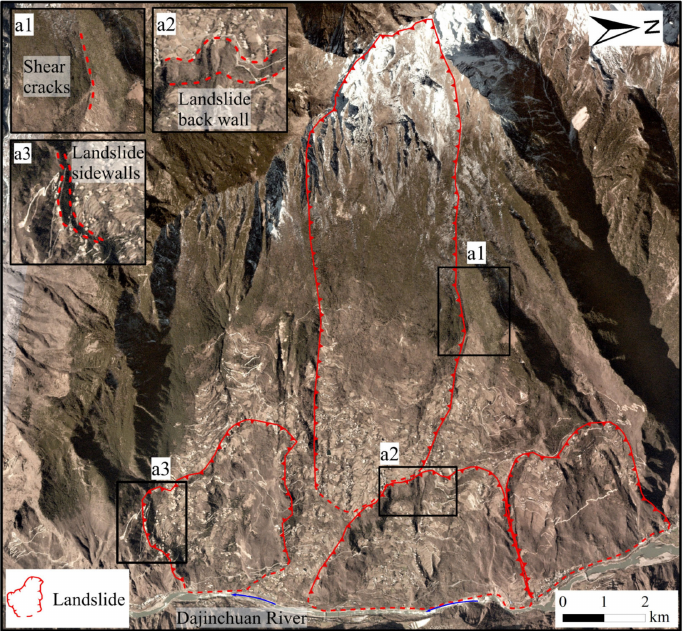
Figure 4. Micro-geomorphology identification of sub landslides from optical remote sensing based on: ( a1 ) shear cracks ( a2 ); landslide back wall; ( a3 ) landslide